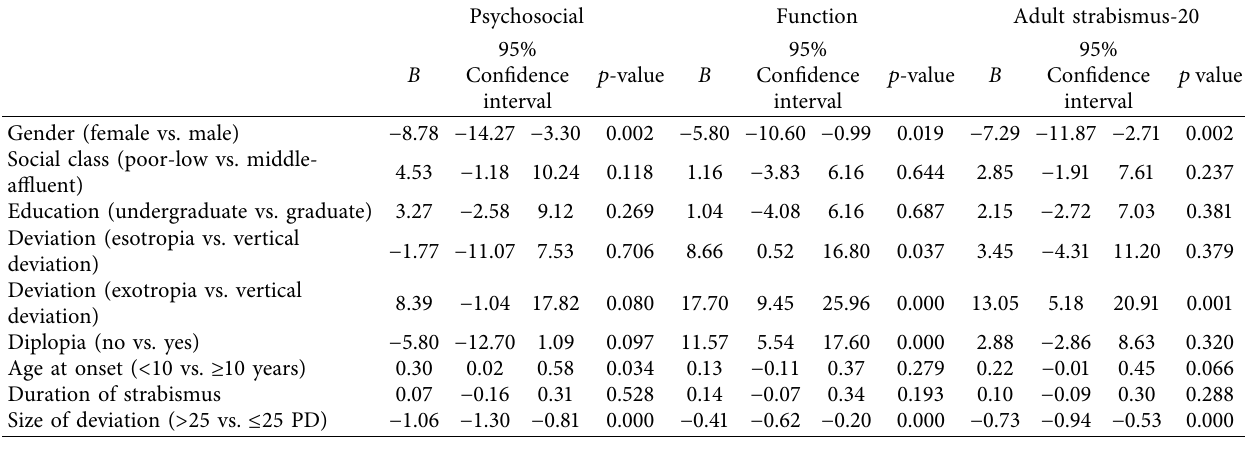
Table 4: Multivariate analysis of factors associated with total AS-20, psychosocial, and function mean scores among patients.